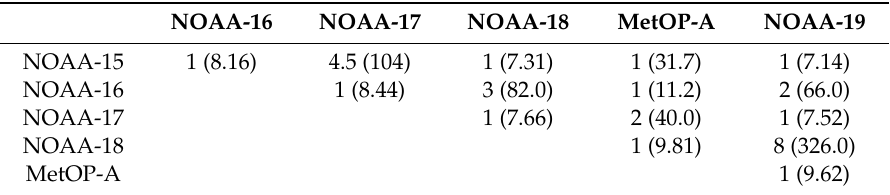
Table 3. Overlap and interval days (in parentheses) for each satellite